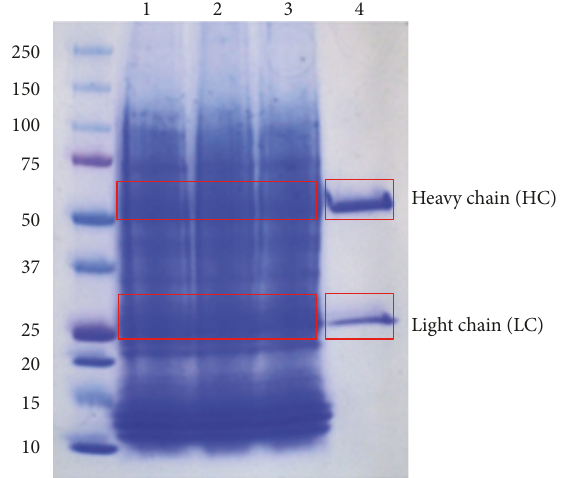
Figure 5: SDS-PAGE result for mutagenized rAb samples (lanes 1-3) and reference rAb glycoprotein (lane 4). Heavy chain and light chain bands were observed at 51 kDa and 26 kDa, respectively.